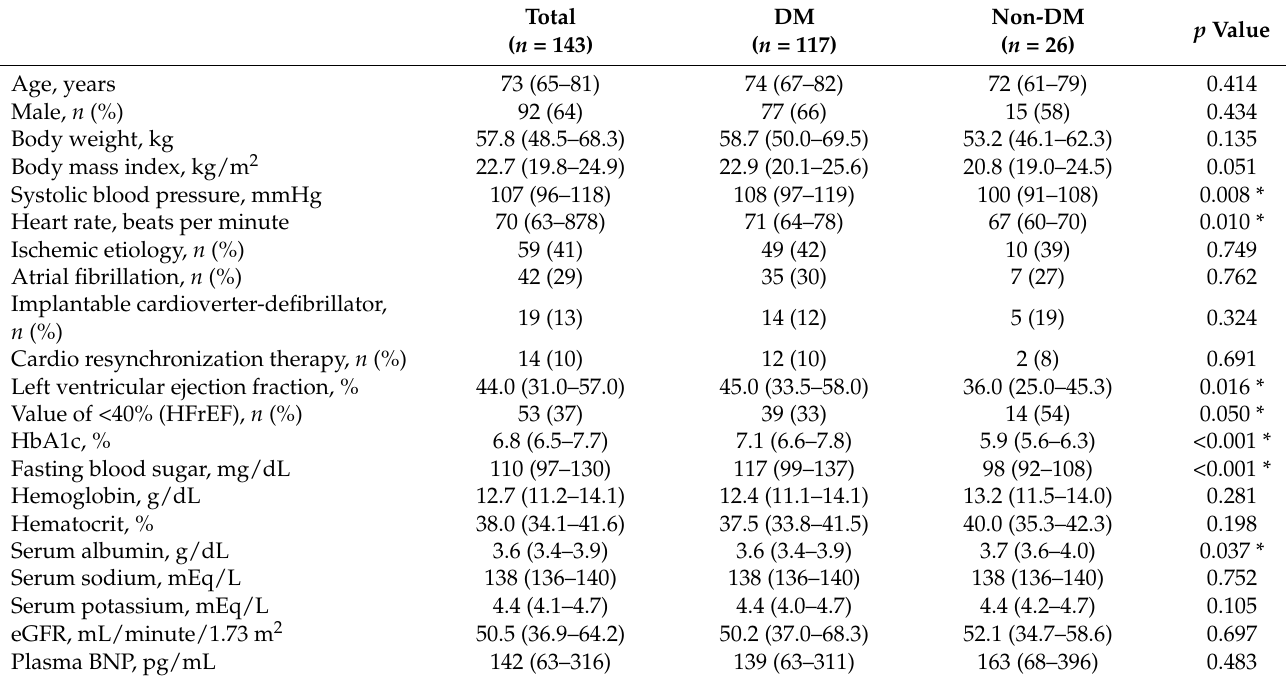
Table A3. Baseline characteristics of the DM/non-DM